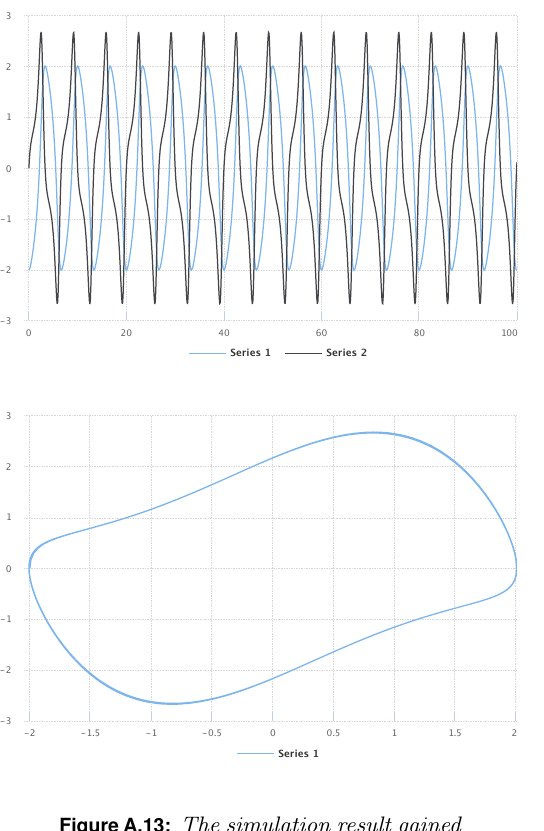
Figure A.14: Simulation with tellurium